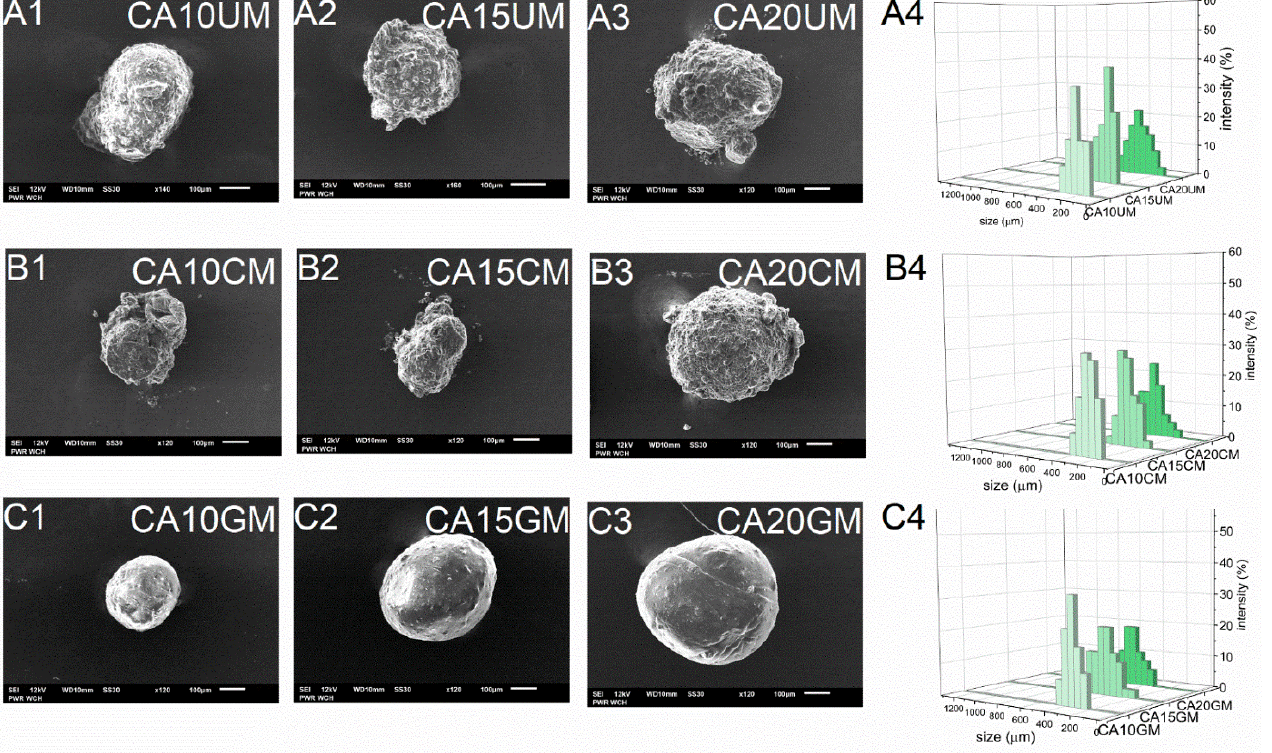
Figure 2. Scanning electron microscopy ( A1 – A3 , B1 – B3 , C1 – C3 ) and size distribution ( A4 , B4 , C4 ) images of CUR-loaded microparticles (see Table 1 for details of the particle composition).